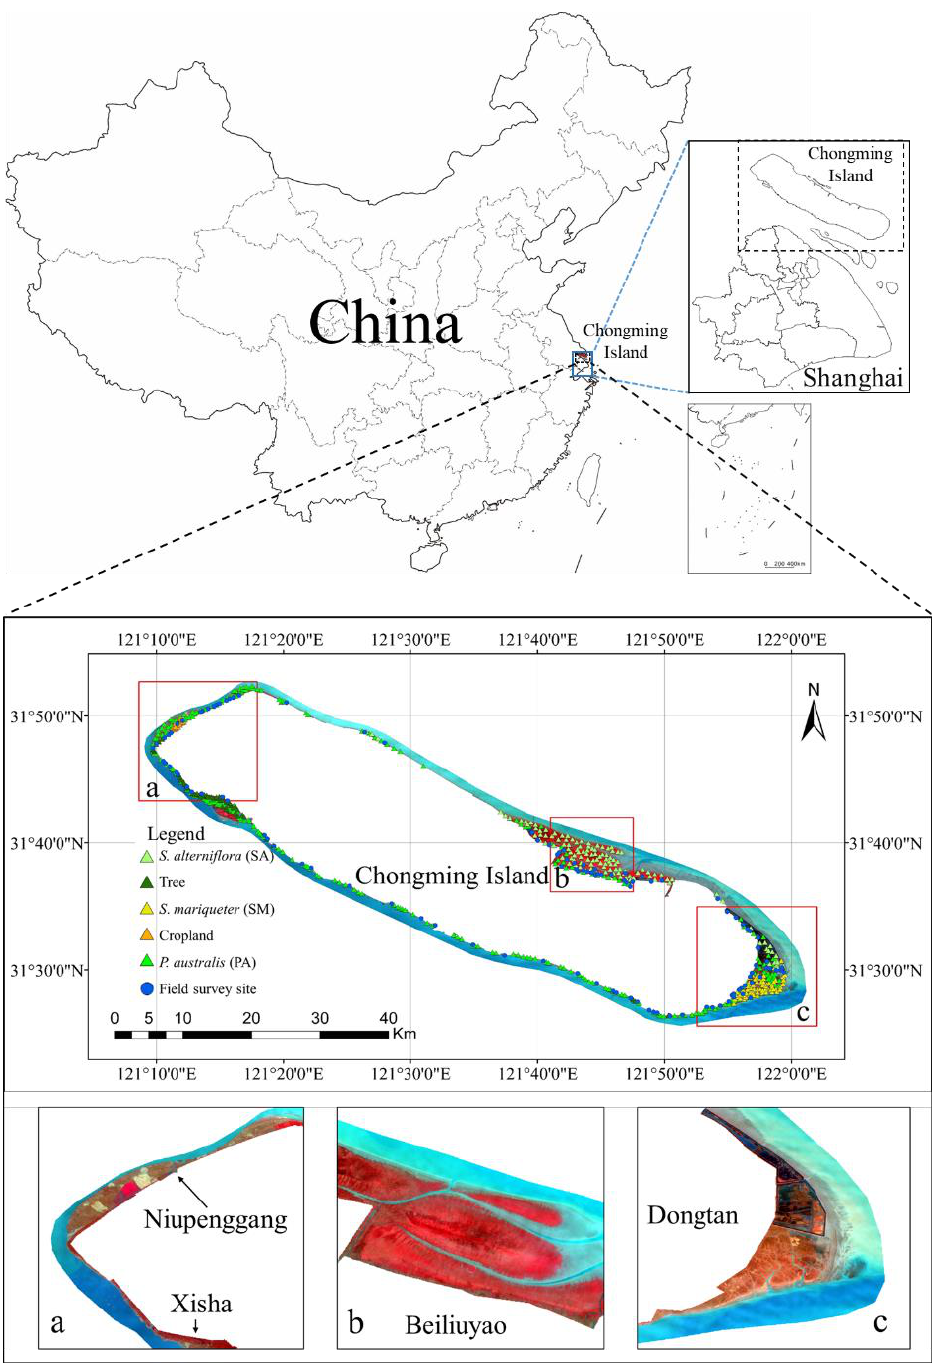
Figure 1. Distribution of the study area. The base map in Figure 1 is from a Landsat 8 Operational Land Imager (OLI) image obtained on 17 December 2018, and displayed in false color with near- infrared, red, and green bands. The subfigures are zoomed-in images and prominently show the main distribution area of the tidal flat wetland vegetation of Chongming Island. Subfigure ( a ) shows the Xisha and Niupenggang areas, subfigure ( b ) shows the Beiliuyao area, and subfigure ( c ) shows the Dongtan area. The triangular points in the legend represent the sample points of various types of vegetation selected in the study, and the blue circular points represent the locations of the field survey sites.